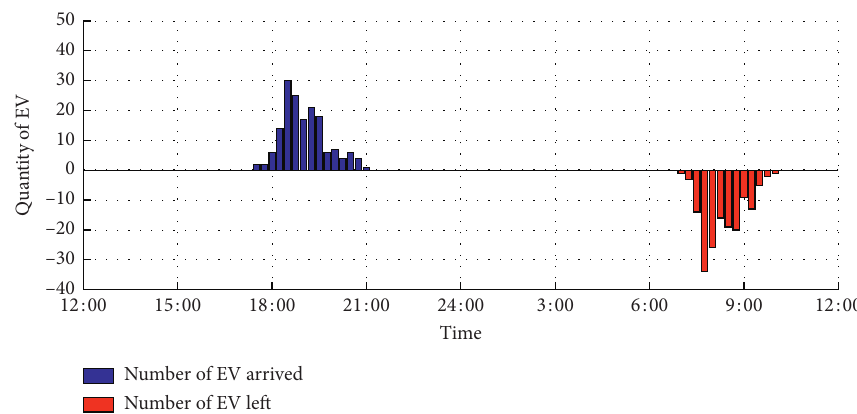
Figure 10: The distribution of vehicle arrival and departure times in this optimization.